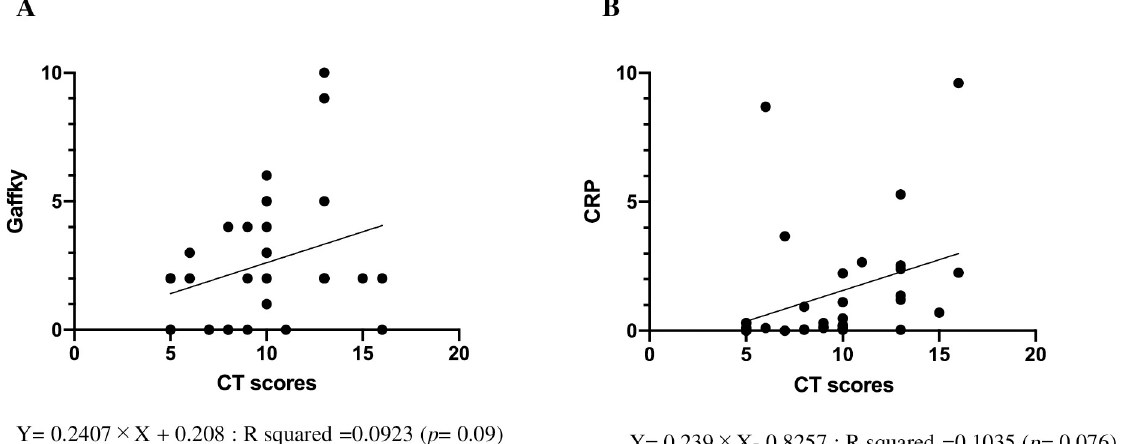
Fig 1. Relationship between CT score at diagnosis and sputum Gaffky score, serum CRP. Correlation between CT score at the timing of diagnosis with sputum Gaffky score (Fig 1A) and CRP (Fig 1B) are shown.